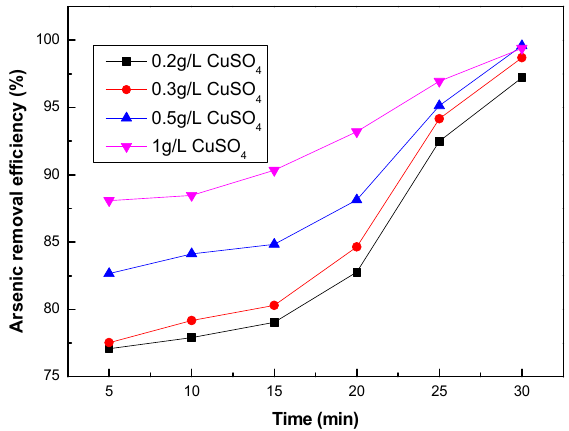
Figure 2. Effect of CuSO 4 concentration on arsenic removal efficiency (experimental conditions: molar ratio of iron to arsenic was 6, reaction temperatures was 20 °C, reaction time was 30 min, and stirring speed was 300 rpm).